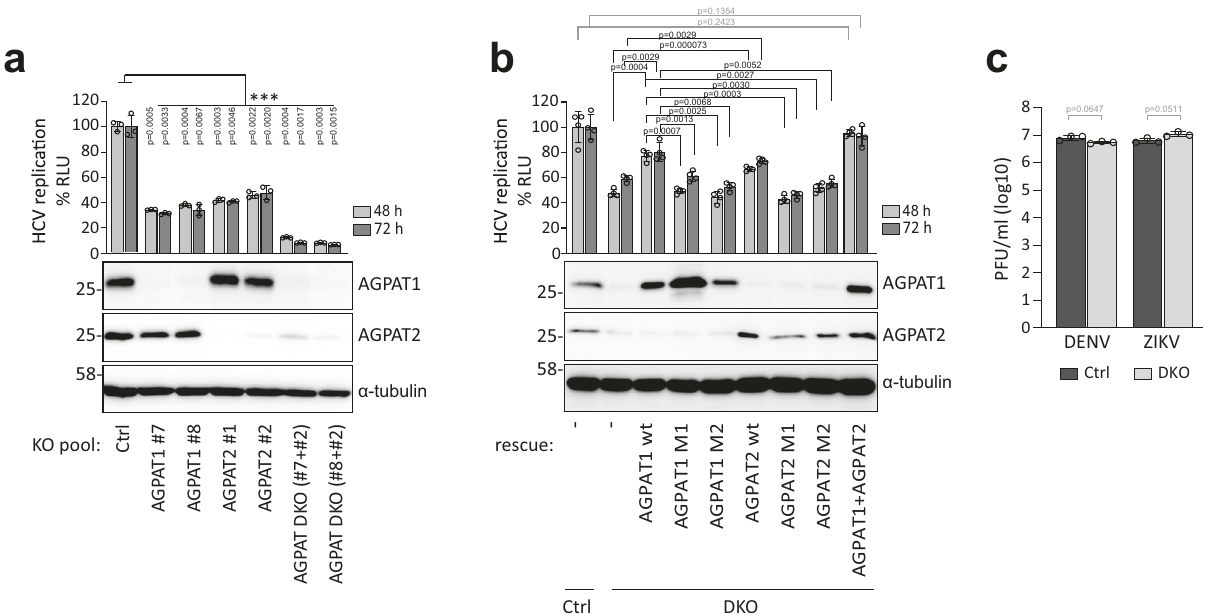
Fig. 2 Enzymatic activity of AGPATs is required for HCV replication. a Effect of AGPAT KO on HCV replication. Huh7.5 cells were infected with lentiviruses encoding AGPAT-targeting-sgRNAs and 5 days later, infected with an HCV reporter virus (JcR2a). After 48 h and 72 h, renilla luciferase activities in cell lysates, re fl ecting viral RNA replication, were quanti fi ed. Graph shows average and SD from three independent experiments. Signi fi cance was calculated by one-tailed paired t -test. p values are shown in graph. Abundance of AGPAT proteins is shown on the bottom. α -tubulin served as loading control. b Enzymatic activity of AGPAT is required for HCV replication. KO cells were reconstituted with sgRNA-resistant AGPAT wild-type (wt) or catalytically inactive mutants (M1 and M2) by lentiviral transduction. Cells were infected with JcR2a, and renilla luciferase activities were quanti fi ed. Graph shows average and SD from four independent experiments. Signi fi cance was calculated by one-tailed paired t -test. p values are shown in graph. Note the complete rescue by AGPAT1 and 2 co-expression. Abundance of AGPAT proteins is shown below the graph; α -tubulin served as loading control. c AGPAT1/2 DKO does not affect DENV or ZIKV propagation. Cells were infected with DENV-2 (strain 16681) or ZIKV (strain H/PF/2013) and 48 h later virus titer was quanti fi ed by plaque assay. Graph shows the average and SD from three independent experiments. Signi fi cance was analyzed by one-tailed paired t -test. p values are shown in graph. PFU, plaque-forming units. Source data for panels a , b and c are provided as Source Data fi